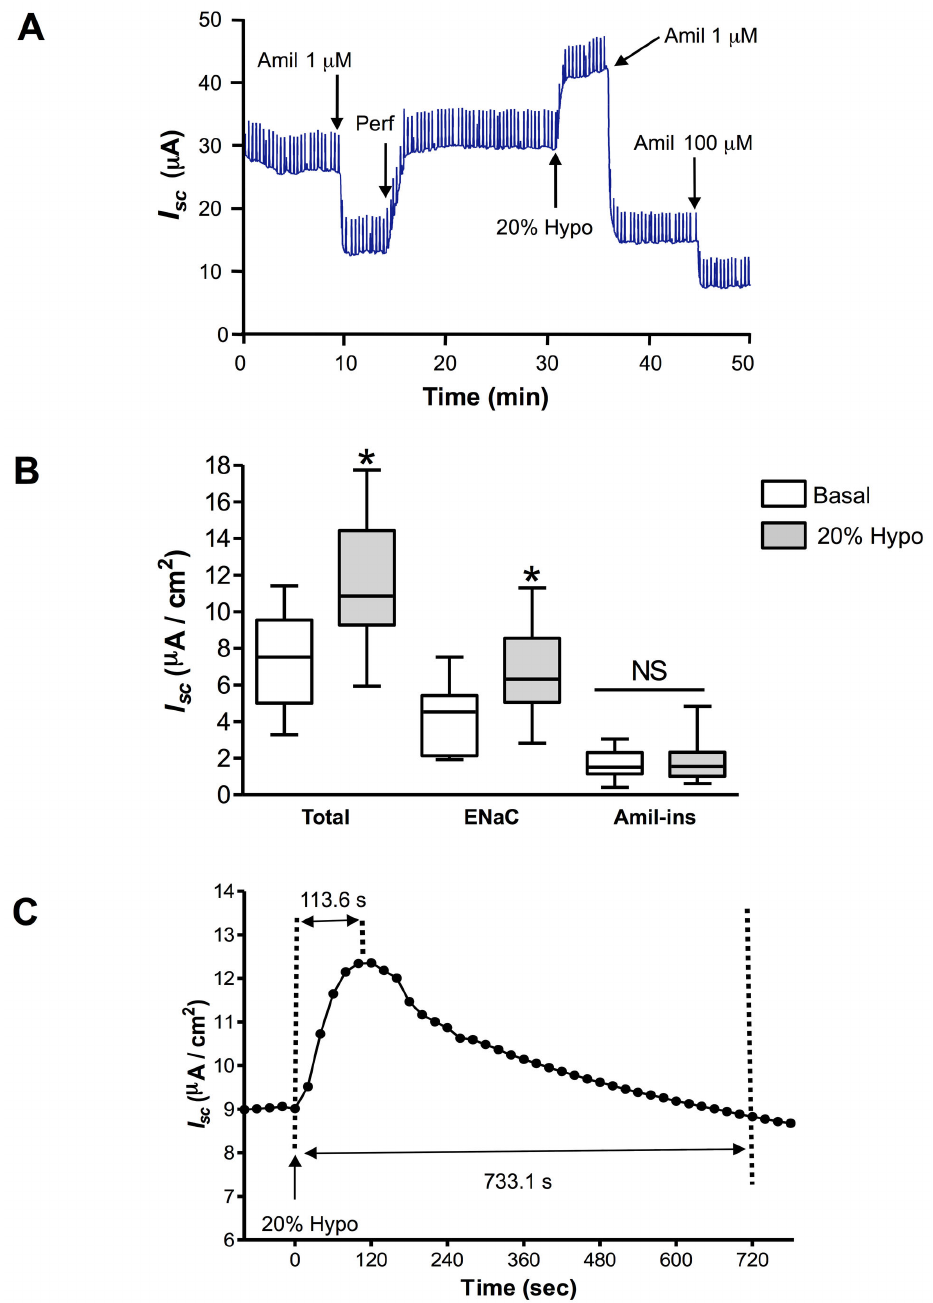
Figure 1. Modulation of I after a 20% hypotonic shock in alveolar epithelial cells. A typical I tracing is depicted in A . ENaC sc sc current was determined after adding 1 µM amiloride (Amil 1 µM) on the apical side. After apical medium perfusion (Perf) to wash away amiloride, the cells were subjected to bilateral 20% hypotonic shock (20% Hypo). Transepithelial resistance (R ) was te monitored throughout the experiment by applying a 1-mV pulse every 10 s (seen as spikes in the I trace). ENaC and amiloride- sc insensitive currents were then tested by adding 1 µM amiloride (Amil 1 µM) and 100 µM amiloride (Amil 100 µM) respectively. Total transepithelial current (Total), 1µM amiloride-sensitive ENaC current (ENaC) and the 100 µM amiloride–insensitive current (Amil- ins) are depicted in B for the untreated control condition (Basal) and after 20% hypotonic shock (20% Hypo). N≥10, *p<0.05 by Mann-Whitney Test between 20% Hypo and Basal. NS: non significant. Mean I from different experiments shows the transient sc nature of the acute rise in the transepithelial current after 20% hypotonic shock ( C ). Mean time to reach maximum current is depicted on top (113.6 ± 7 s; N=17). The time to return to basal values is depicted at the bottom (733.1 ± 120 s; N≥5). doi: 10.1371/journal.pone.0074565.g001 PLOS ONE |